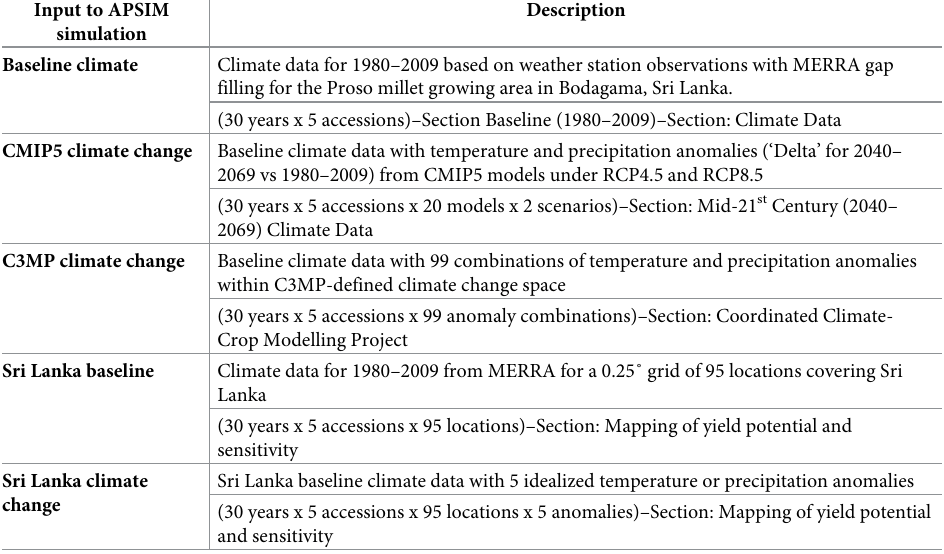
Table 2. Different types of yield simulations performed using the APSIM model.